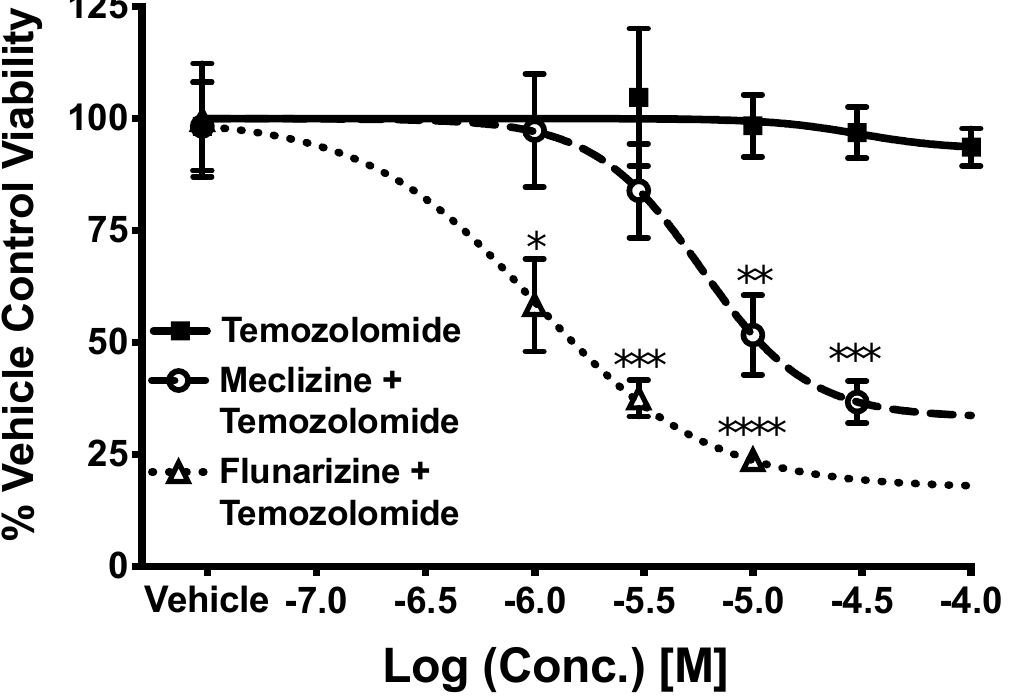
Figure 5. Meclizine and flunarizine co-administered with temozolomide, the current standard of care for GBM. Experiments were conducted using Trypan Blue Exclusion in patient-derived GBMsc. Experimental points are the average of 3 experiments. Error bars are the standard error of the mean. The curve is a four-parameter-model sigmoidal dose–response curve. The X-axis is drug concentration, while the Y-axis is % viability of GBSC normalized to vehicle control. Best-fitting values for the co-administration of meclizine and temozolomide were: IC50 = 5.7 µ M, Rmin = 33.27, R2 = 0.99, p = 7.5 × 10 − 8 . Best fitting values for flunarizine and temozolomide were: IC50 = 1.0 µ M, Rmin = 17.50, R2 = 0.99, p = 4.5 × 10 − 5 . Values for temozolomide alone: IC50 = 3.2 × 10 − 5 , Rmin = 93.2, R2 = 0.71, p -value = 3.5 × 10 − 2 . n = 4 for vehicle, 3 for each concentration of temozolomide, 3 for each concentration of meclizine + temozolomide, 3 for each concentration flunarizine + temozolomide. The total number of measurements are 3, 12, 12, and 9 for vehicle, temozolomide, meclizine + temozolomide, and flunarizine + temozolomide, respectively. *, **, ***, and **** correspond to p values less than 0.05, 0.001, 0.0001, and 0.00001 respectively.